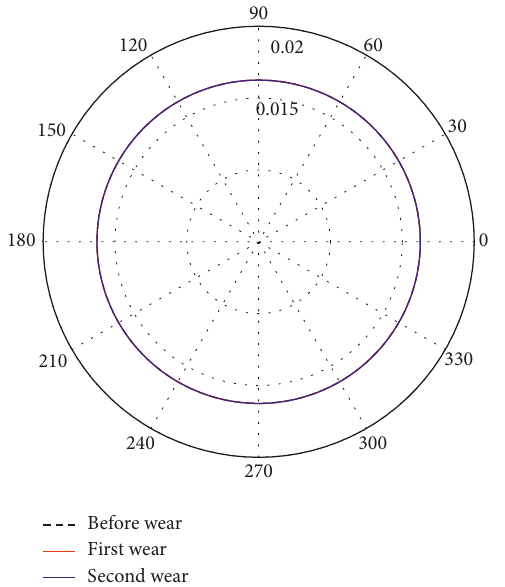
Figure 12: Local enlarged drawing of the shaft surface of joint B .